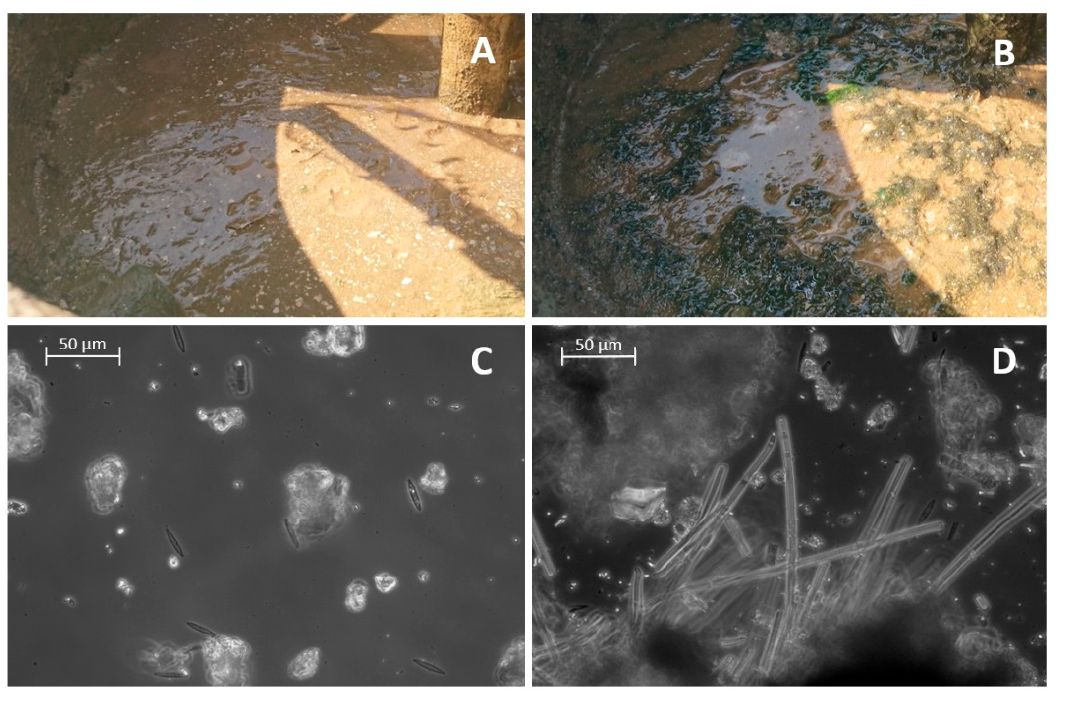
Figure 1. Biofilm deposit in the basins of the cooling tower fed with reverse osmosis (RO) permeate poor in nutrients ( A ) and the cooling tower fed with RO permeate enriched in nutrients ( B ) and associated microscopic pictures ( C , D ) respectively.